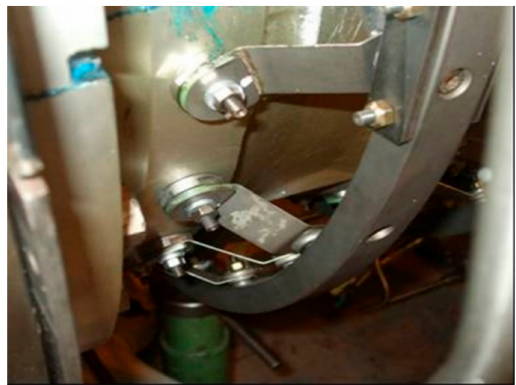
Figure 29. Failure in the VSGV mechanism in the axial compressor. One of the moving guides has been loosened from the fixed frame of reference.